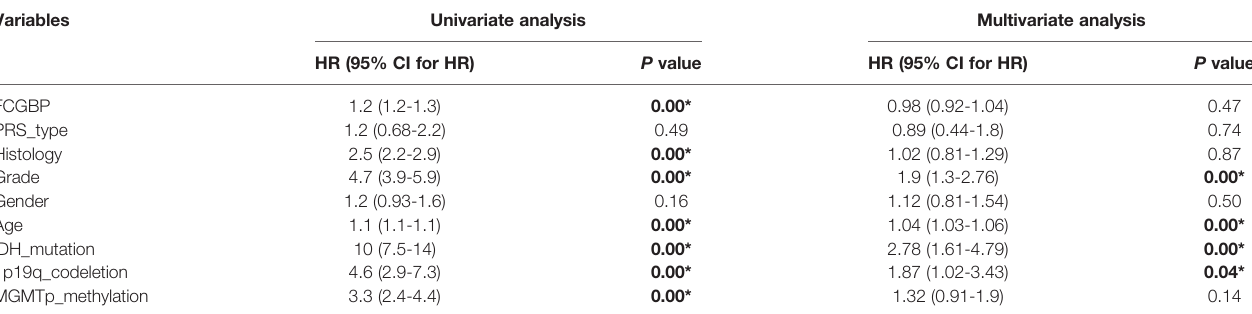
TABLE 1 | Cox regression analysis of the clinical variables, and overall survival in TCGA cohorts.